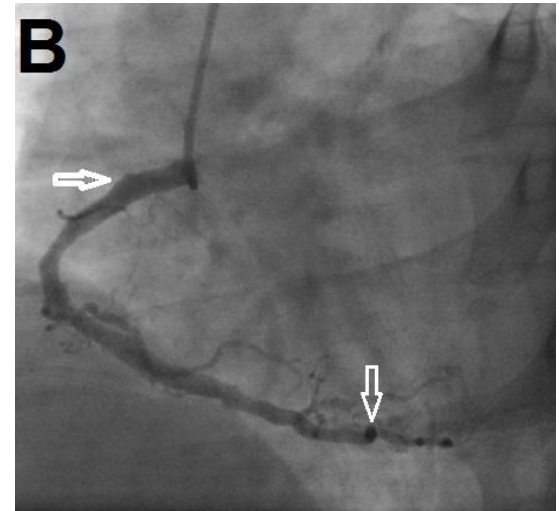
Figure 3B. Right coronary artery: some ectasias and plaques throughout